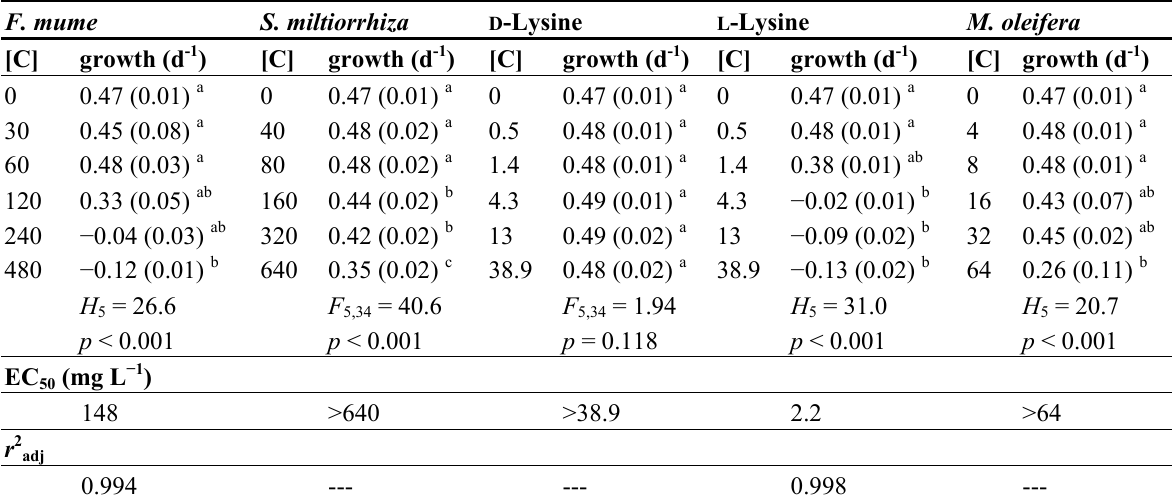
Table 3. Chlorophyll- a based growth rates (d − 1 ) of Microcystis aeruginosa NIVA-CYA 43 exposed to different concentrations (C, mg L − 1 ) of extracts from Fructus mume , Salvia miltiorrhiza , Moringa oleifera and D - and L - lysine, including F- and P -values of one-way ANOVAs, or H -values of Kruskal-Wallis One Way Analysis of Variance on Ranks. Values between brackets indicate one standard deviation ( n = 5). Similar letters per column ( a,b,c ) indicate homogenous groups that are not different at the p = 0.05 level. Also given are EC values (mg L − 1 ) and adjusted r 2 of non-linear regression (four parameter logistic curve). F. mume S. miltiorrhiza D -Lysine L -Lysine M. oleifera